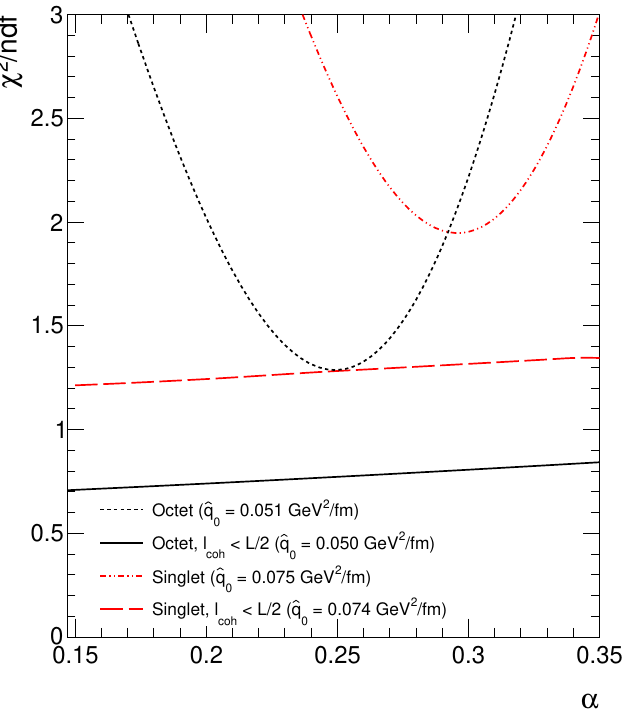
Figure 3 . (cid:31) 2 = ndf pro(cid:12)le from the (cid:12)ts to all and low ‘ coh < L= 2 data, assuming Q (cid:22) Q pairs to be produced in a color octet (respectively, dotted and solid) and color singlet (dash-dotted and dashed)